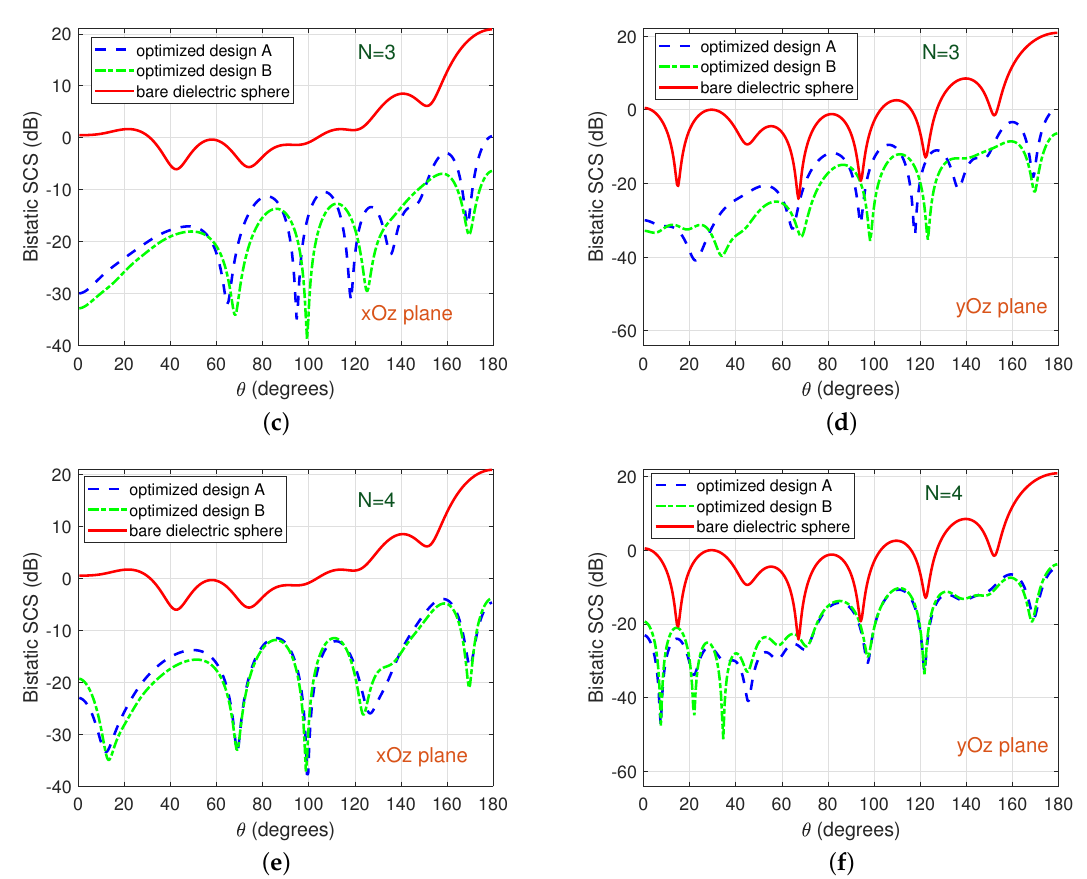
Figure 7. Normalized bistatic SCS σ ( θ , φ ) / ( π a 2 c ) in the xOz and yOz planes versus the angle θ for ( a , b ) N = 2, ( c , d ) N = 3, and ( e , f ) N = 4 optimized spherical layers covering a dielectric core of radius k 0 a c = 2 π and permittivity (cid:101) c = 2.1, excited by a dipole at b = 10 a c . The values of the optimization variables for designs A and B are given in Table A5 of the Appendix